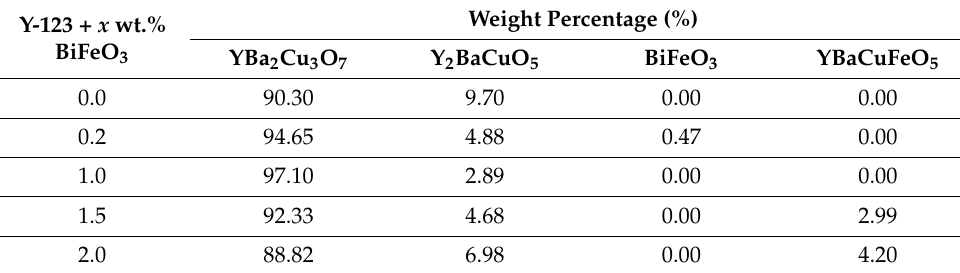
Table 1. Weight percentages of the phases presented in the samples for the Y-123 + x wt.% of BiFeO 3 . Y-123 + x wt.%